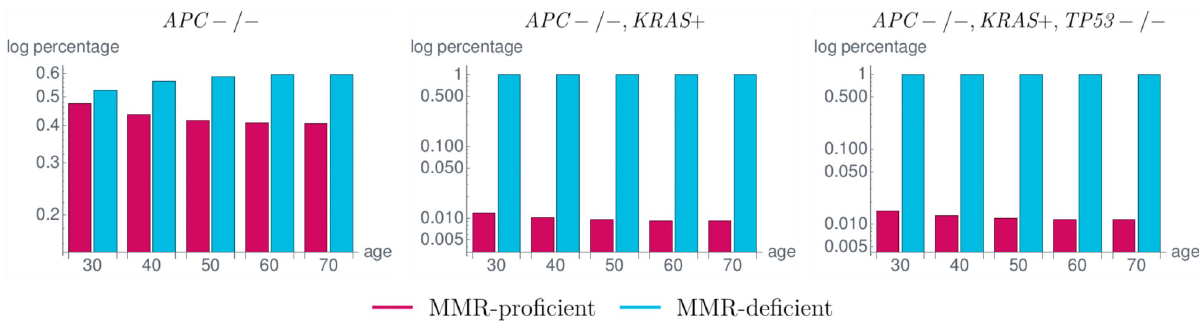
Fig 11. Proportion of MMR-proficient and MMR-deficient crypts in a typical MLH1 carrier in different states corresponding to the states in the classical adenoma-carcinoma sequence by Vogelstein [7]. Among the APC -/- crypts (left), the number of MMR-deficient crypts is up to 20% higher than the number of MMR-proficient ones. This difference largely increases with the subsequent KRAS activation ( KRAS +) (middle) and TP53 inactivation ( TP53 -/-) (right) leading to the fact that almost all crypts in the last state, corresponding to a cancerous state, are MMR-deficient. These simulation results are in concordance with available data with a slight underestimation of MMR-deficient APC -/- crypts [22].